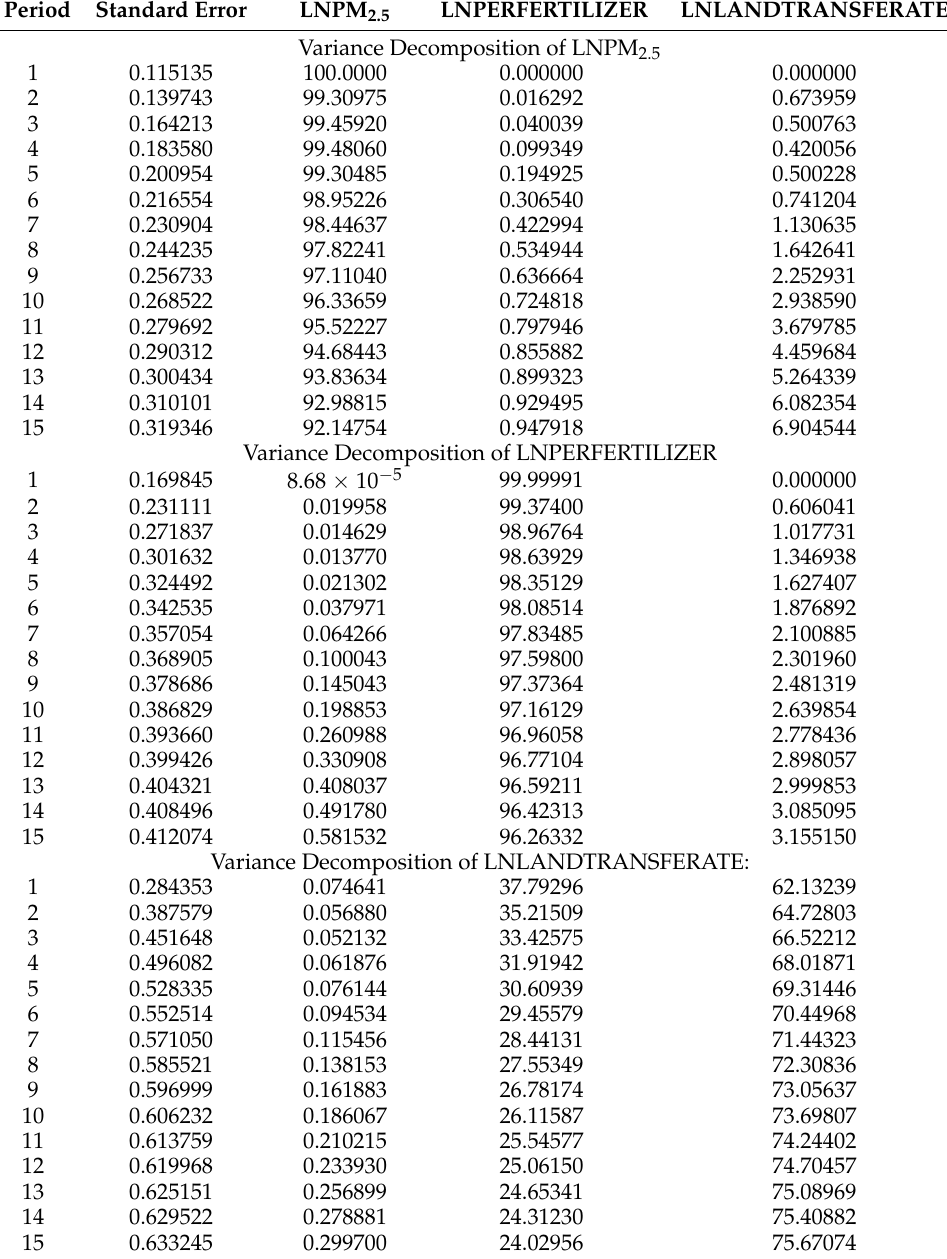
Table 7. Variance decomposition